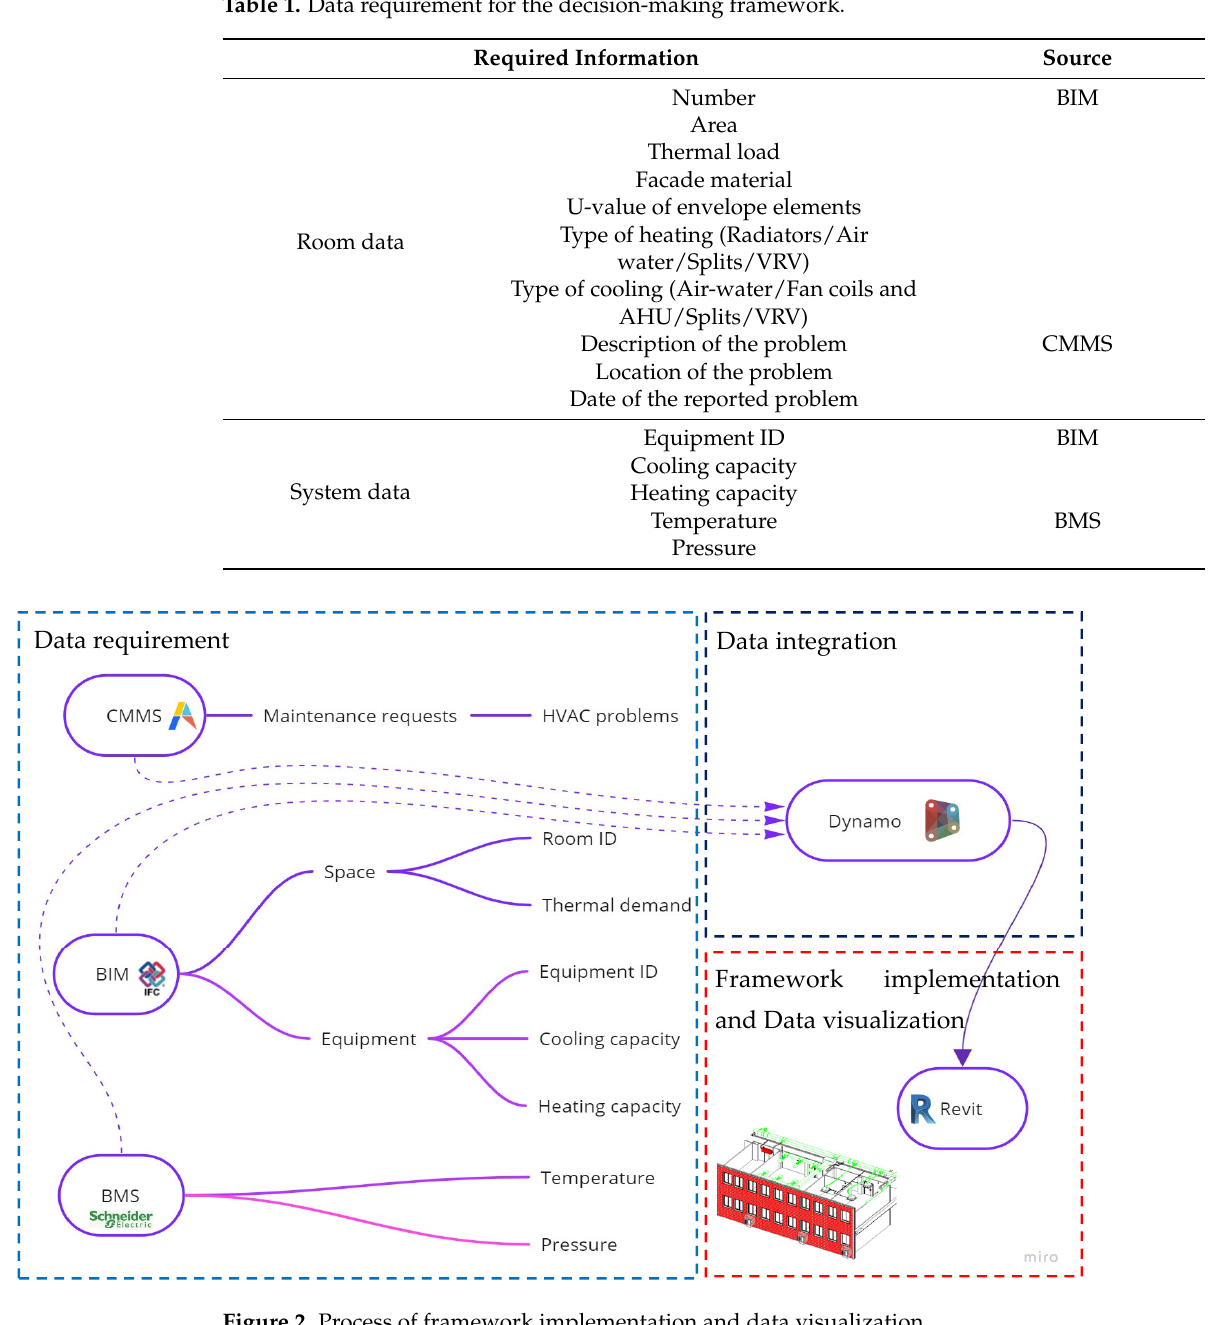
Table 1. Data requirement for the decision-making framework. Required Information